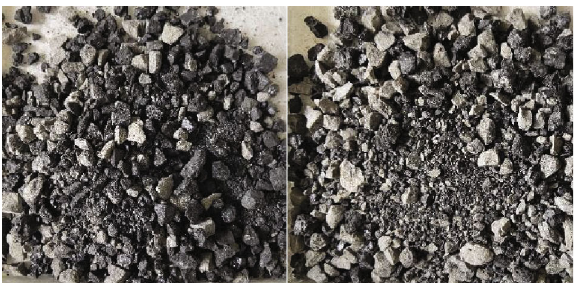
Figure 10: C2 and C3 samples after loading and unloading